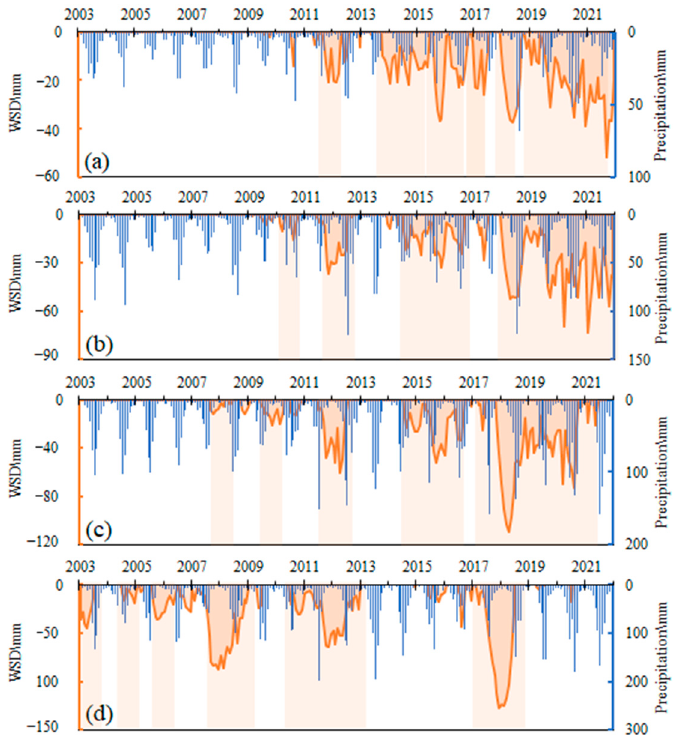
Figure 9. Water storage deficit based on GRACE in different climate zones (Blue histogram: Precipita- tion, orange shaded areas: Water storage deficits